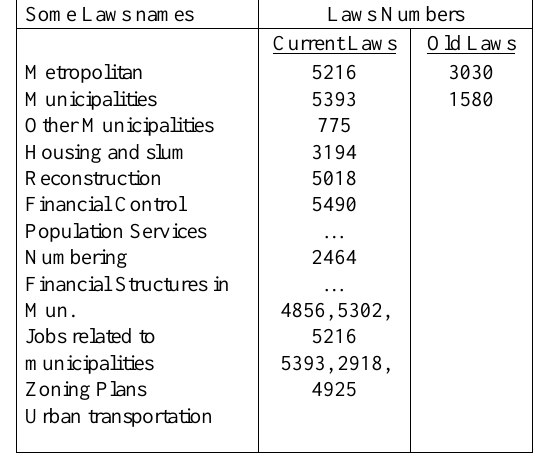
Table 1. Current or changed some legislation about